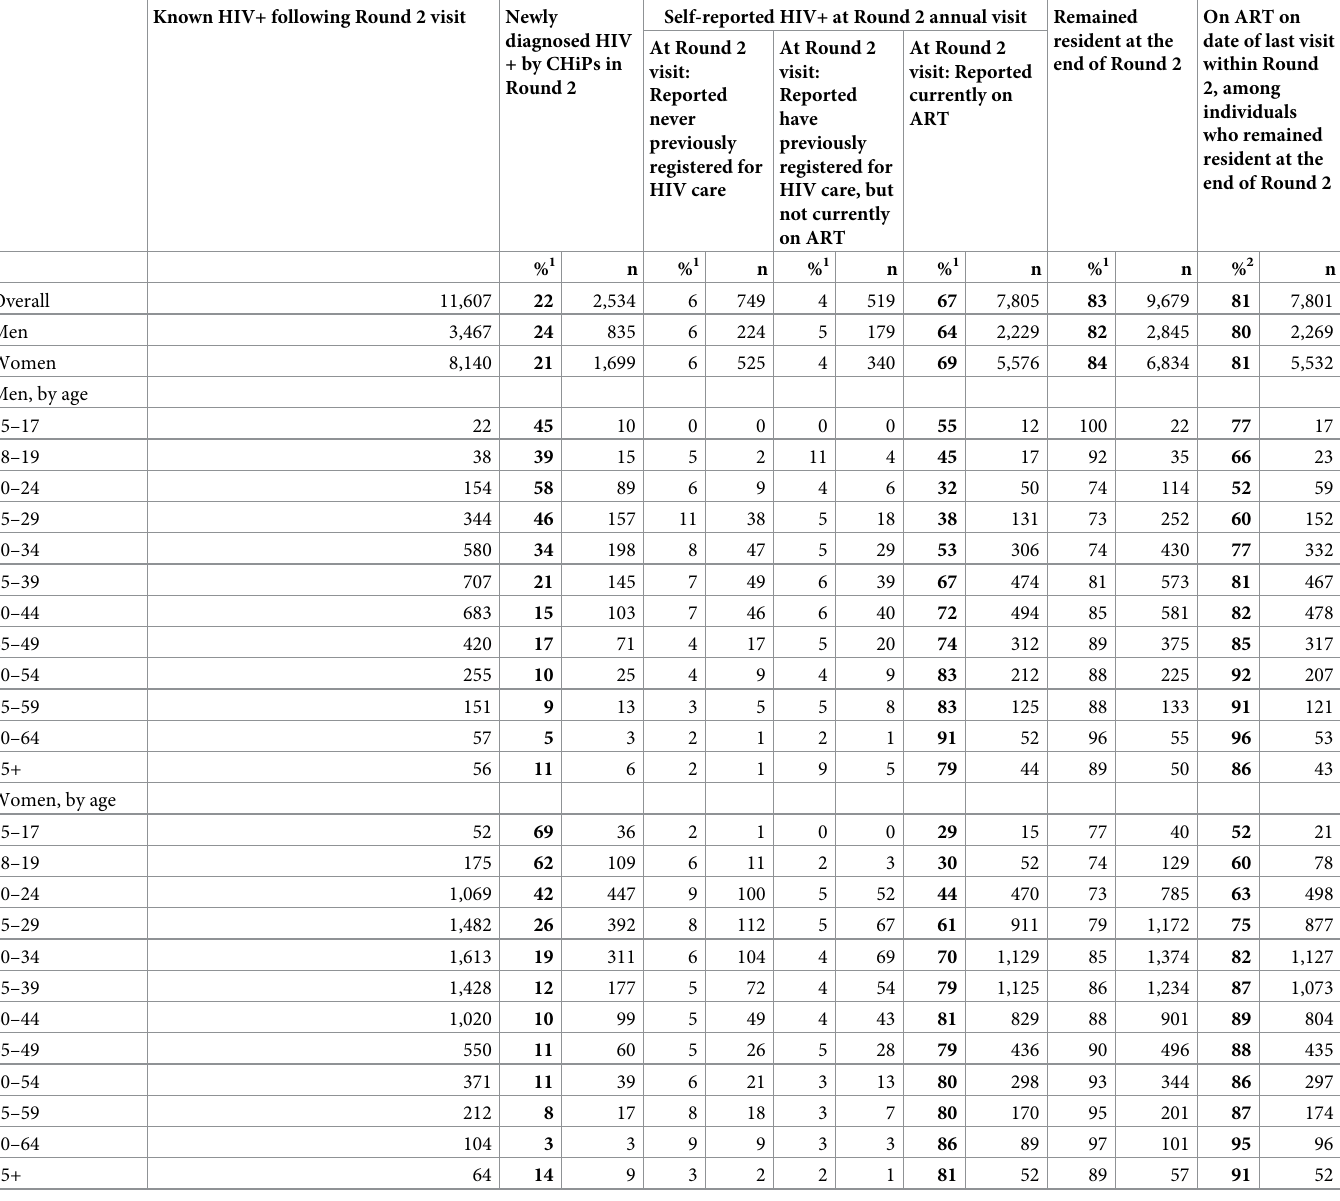
Table 2. ART uptake among known HIV-positive individuals who participated in Round 2, at the start and by the end of Round